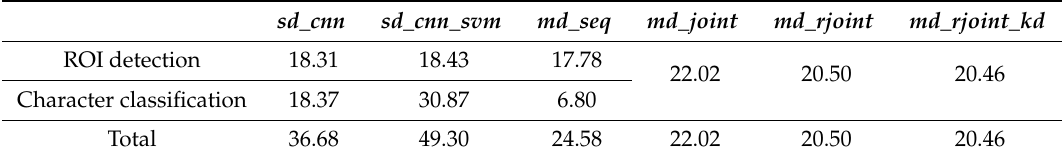
Table 3. Inference time (msec).